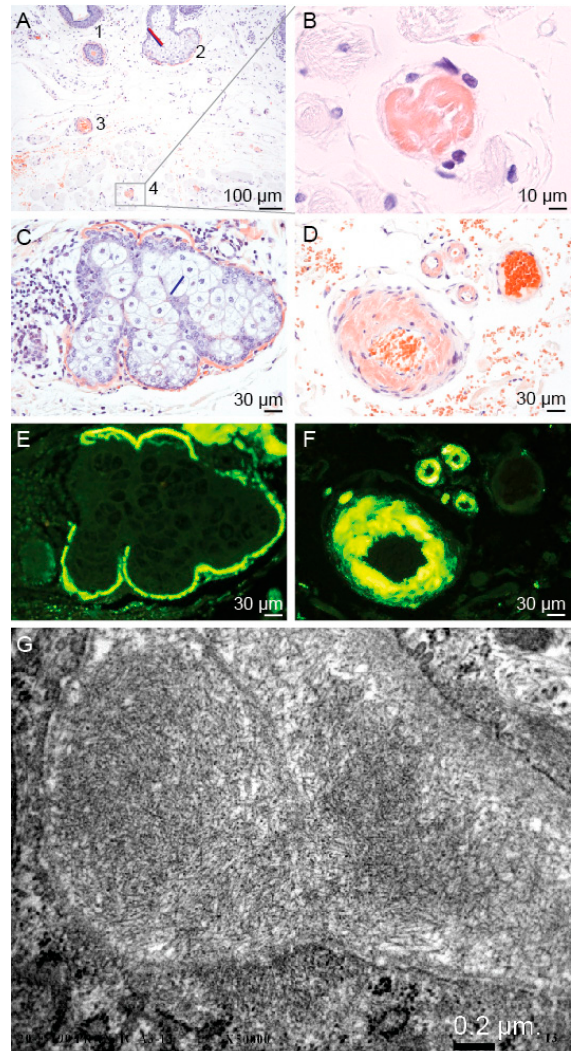
Figure 5. Histopathological analysis of the right upper eyelid blepharoplasty specimen of the patient II-1. A Congo red stain shows amyloid deposition at the basal membrane of a hair follicle ( 1 ) and a sebaceous gland ( 2 ), within a vessel wall ( 3 ) and within a skeletal muscle cell ( 4 ) ( A ). Higher magnifications showing amyloid deposition within a skeletal muscle cell ( B ) (higher magnification of the area depicted in ( A ), around a sebaceous gland ( C ) and within vessel walls of a small artery and arterioles ( D ). Amyloid deposits highlighted by thioflavin T stain around a sebaceous gland ( E ) and within vessel walls ( F ). Areas in ( E ) and ( F ) correspond to ( C ) and ( D ), respectively. Electron microscopy ( G ) shows amyloid fibrils within the vessel wall, beneath an endothelial cell (upper